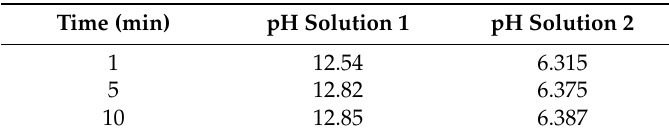
Table 4. Solution pH at different times.